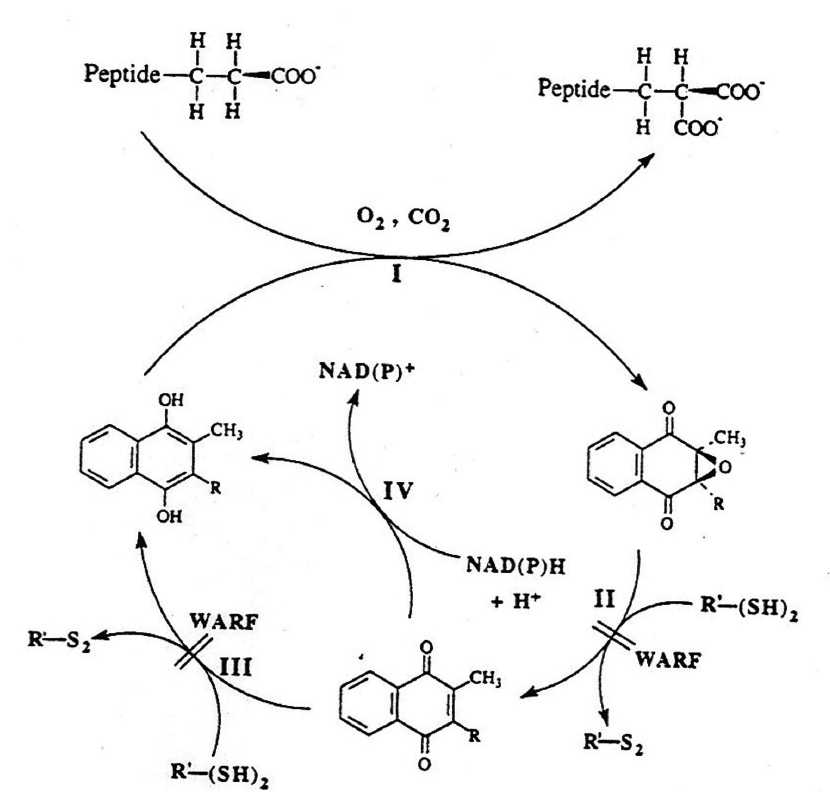
Figure 1. The enzyme reactions involved in the metabolic function of vitamin K. Vitamin K-dependent carboxylase catalyzes the transformation of peptide- (Factors II, VII, IX, and X) bound glutamate residues (Glu) to γ -carboxyglutamate (Gla) residues in the presence of vitamin K hydroquinone, carbon dioxide, and molecular oxygen (I). Vitamin K hydro- quinone is oxidized in the reaction to vitamin K 2,3 epoxide. The reduction of the latter to vitamin K quinone is catalyzed by vitamin K epoxide reductase, which can use certain dithiols as the reductants (II). Vitamin K quinone can be reduced to vitamin K hydro- quinone in the reactions catalyzed by either a dithiol-dependent (III) or an NAD(H)P- dependent (IV) entzyme. Warfarin (WARF) blocks reactions II and III. (Uotila L. Recent findings on the functions and requirements of vitamin K in humans. Klinlab